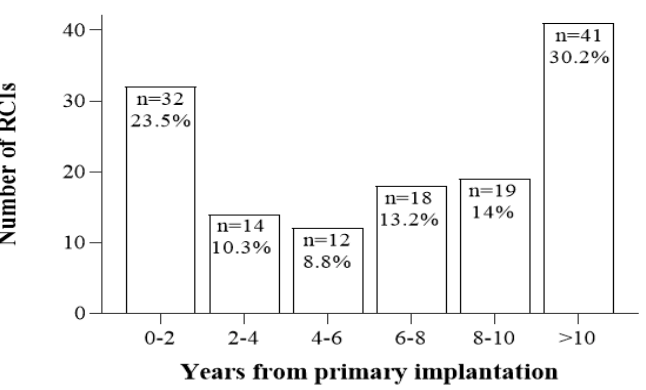
Figure 2. Time interval between primary cochlear implantation and revision surgery. Inclusion cri- teria for this analysis was cases with ≥ 10 years of follow-up ( n = 136). The percentages refer to the